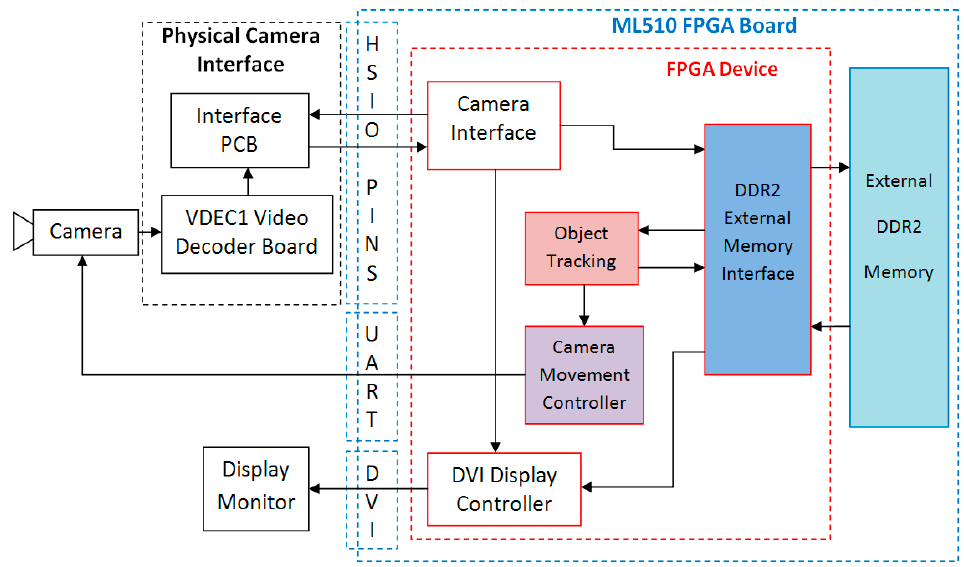
Figure 2. Dataflow diagram of the proposed and developed object tracking system.